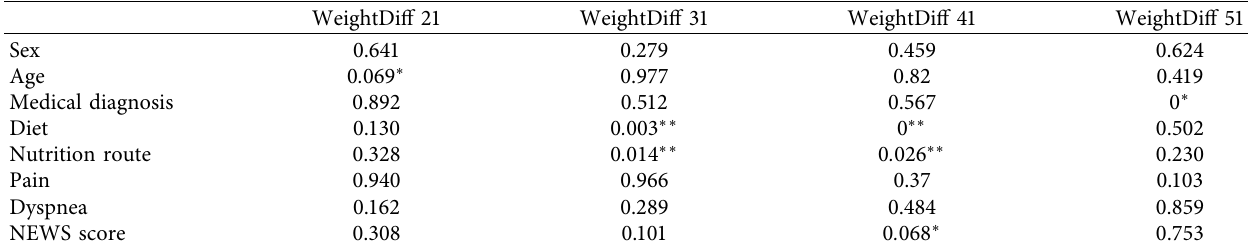
Table 6: p value for one-way ANOVA for weight difference on day t for all risk factor